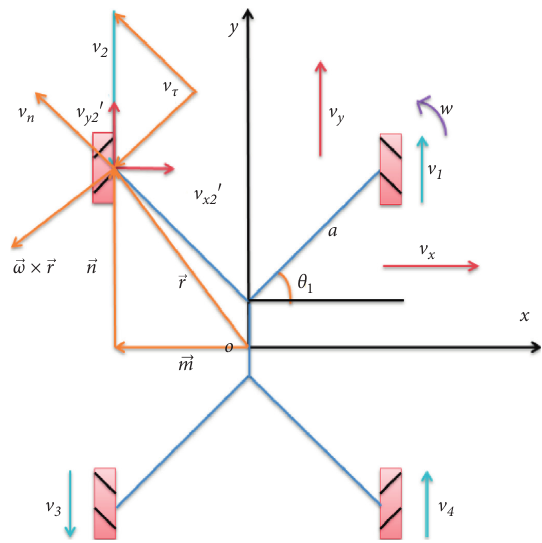
Figure 8: Map of the wheel chassis